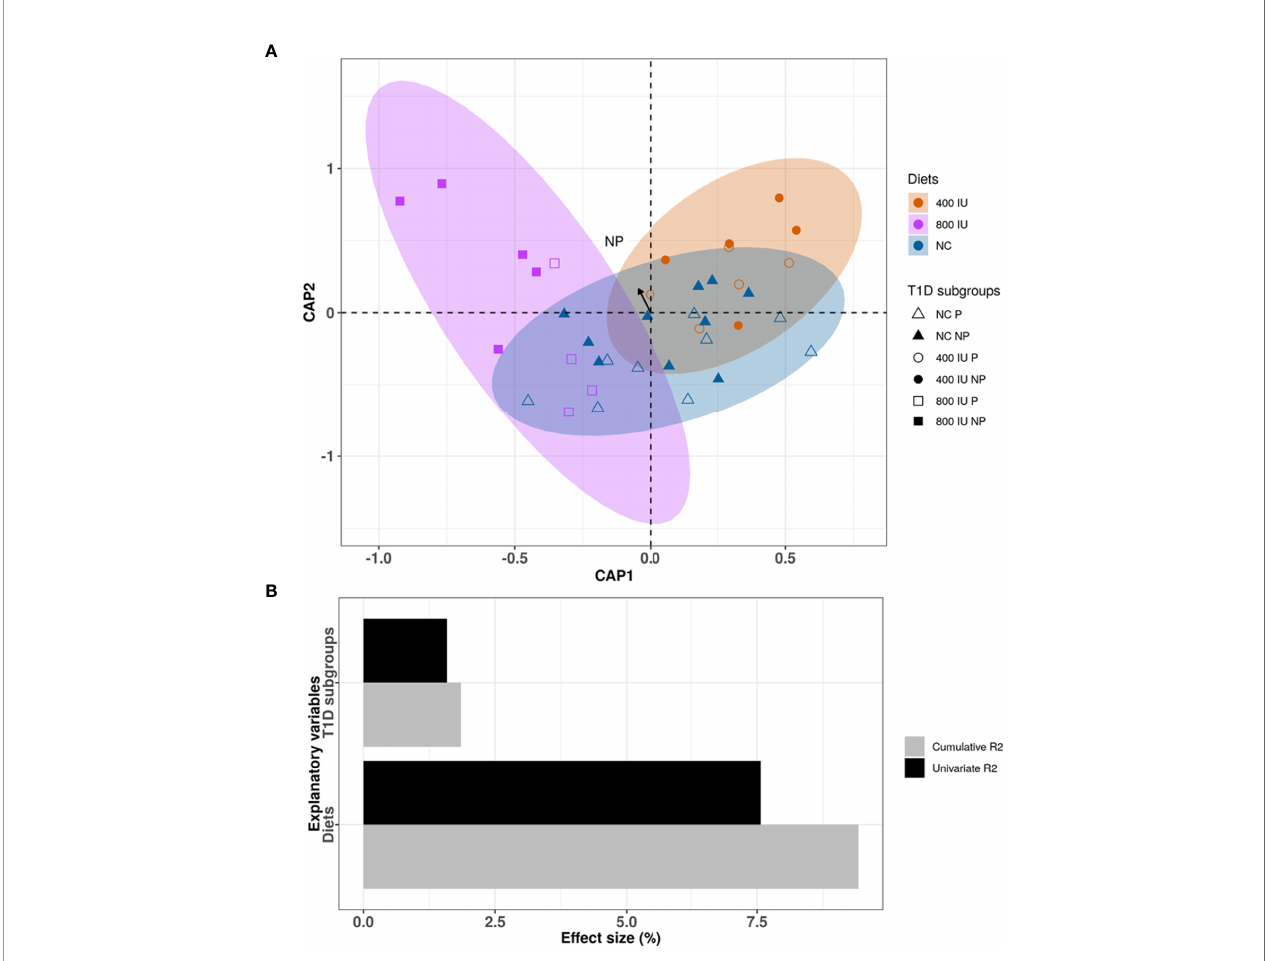
FIGURE 7 | Differences in microbial community composition between NOD mice receiving normal chow (NC), 400 IU/day or 800 IU/day vitamin D-supplemented diet and T1D subgroups at 8 weeks of age. Canonical analysis of principal coordinates (CAP) visualization of inter-mice differences in the microbiome pro fi les of the NOD mice cohort at 8 weeks of age (N = 38 biologically independent samples, data points coloured by diet and disease outcome subgroups denoted by shape). The fi gure is strati fi ed by dietary subgroups depicting the differences in microbial composition of the mice receiving NC (N = 38 paired samples, blue), 400 (N = 20 paired samples, orange) or 800 IU/day (N = 18 paired samples, purple) vitamin D-supplemented diets at 8 weeks of age. The arrow points to the centroid of the T1D NP subgroup (A) . Bar plot representation of the explanatory power of the diet and disease outcome on the NOD microbiota compositional variation in a single variable model (univariate effect size [R2]) or combined in a multivariate model (cumulative R2) (B) . Statistical signi fi cance was calculated by distance-based redundancy analysis (Bray-Curtis dissimilarity